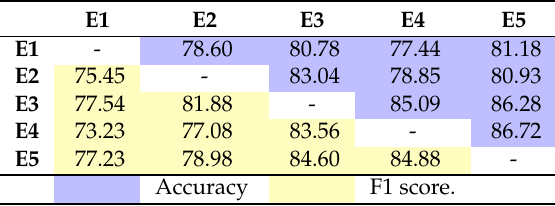
Table 1. Accuracy and F1 score between writhing movement (WM) fragments selected by individual experts pairwise.